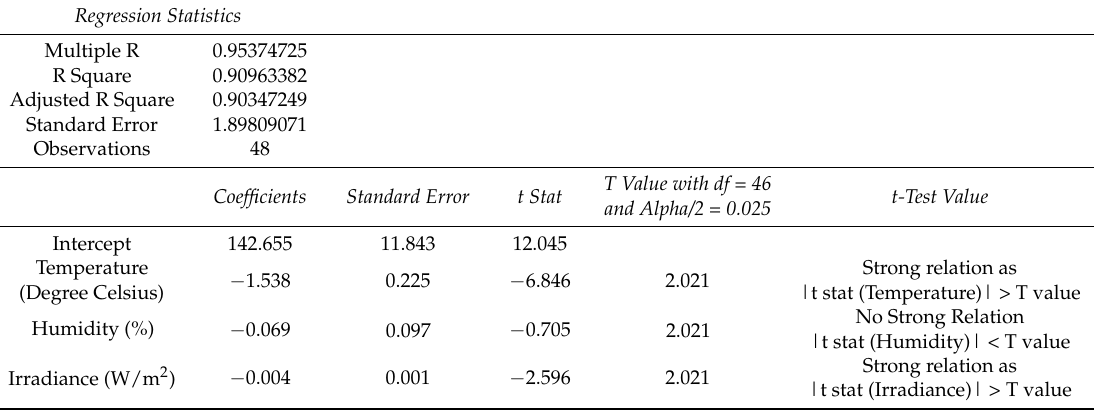
Table 4. Regression analysis output and t-test approach on the data for month of December.